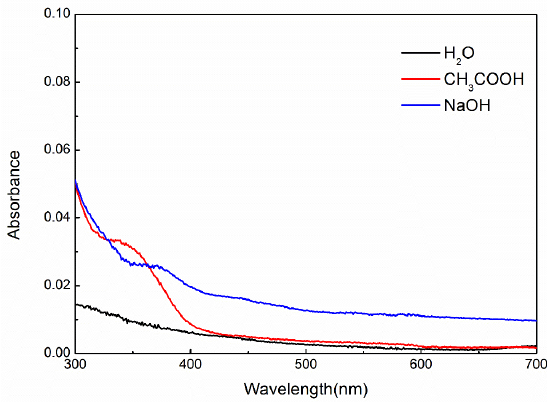
Figure 10. UV-Vis spectra of AuNPs@VCS-4.85 immersed in H 2 O, NaOH, and CH 3 COOH.